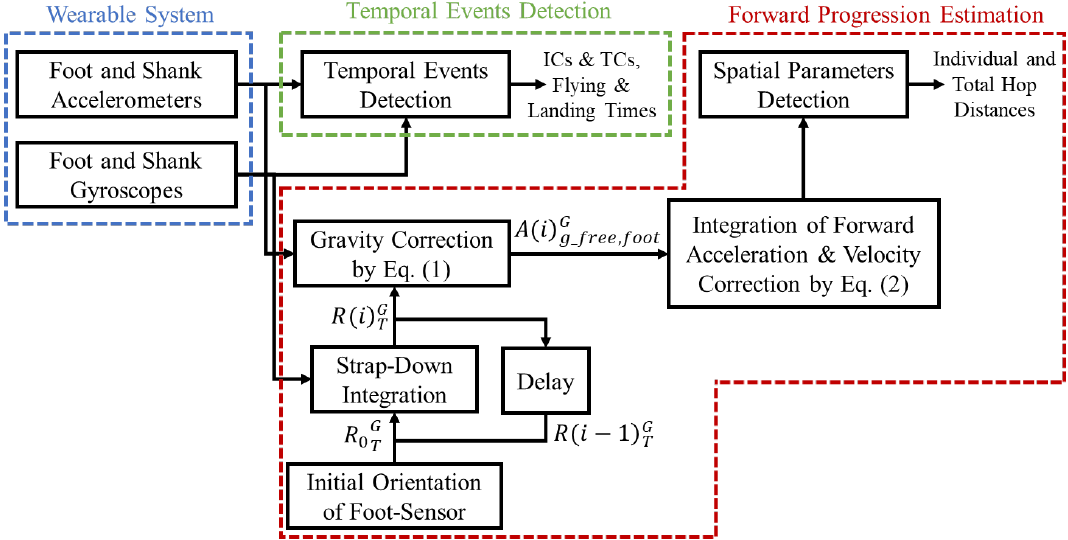
Figure 1. The flowchart of the proposed procedure for detecting triple single-leg hop (TSLH) temporospatial parameters using inertial measurement units (IMUs). Each step is described in detail in the sections distinguished with dashed lines. The box labelled as “Delay” brings the newly calculated foot-sensor orientation at the current time instant back to the strap-down integration box to estimate the foot-sensor orientation in the next time instant.